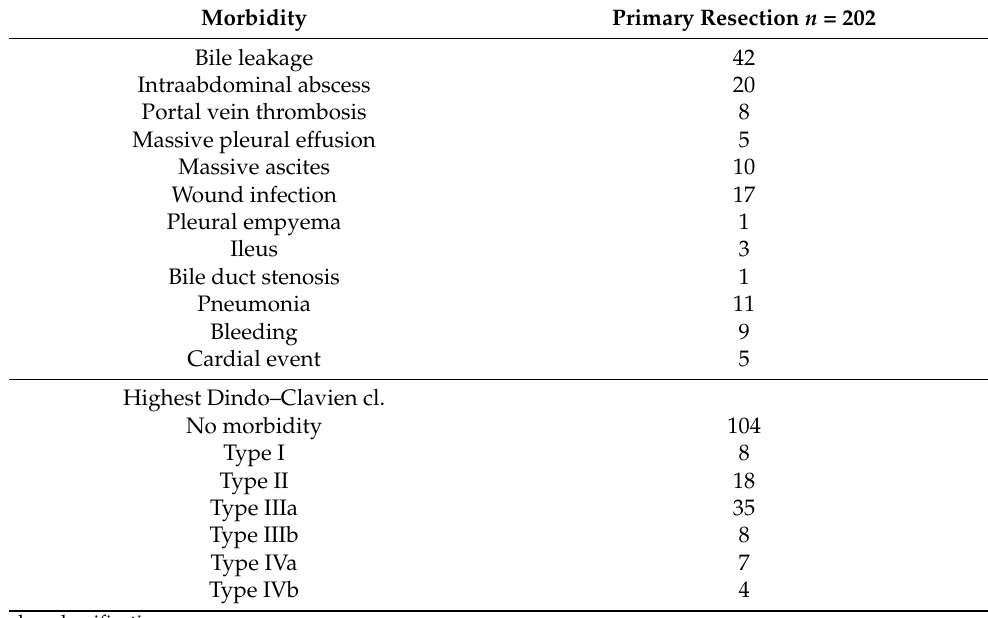
Table 4. Morbidity after primary